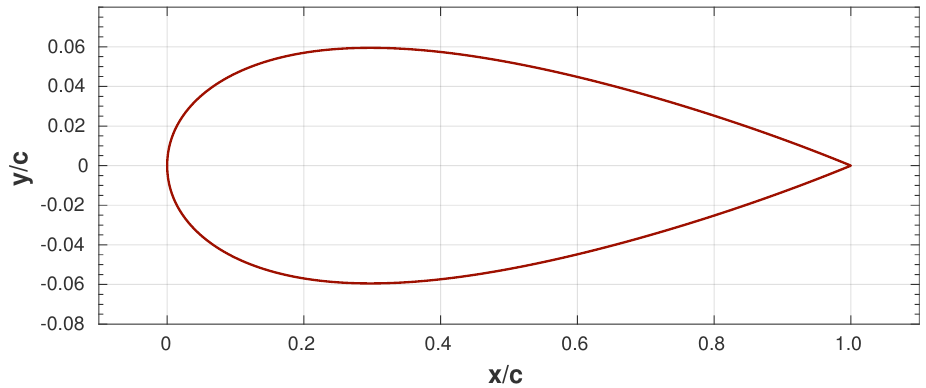
Figure 2. NACA 0012 airfoil geometry.